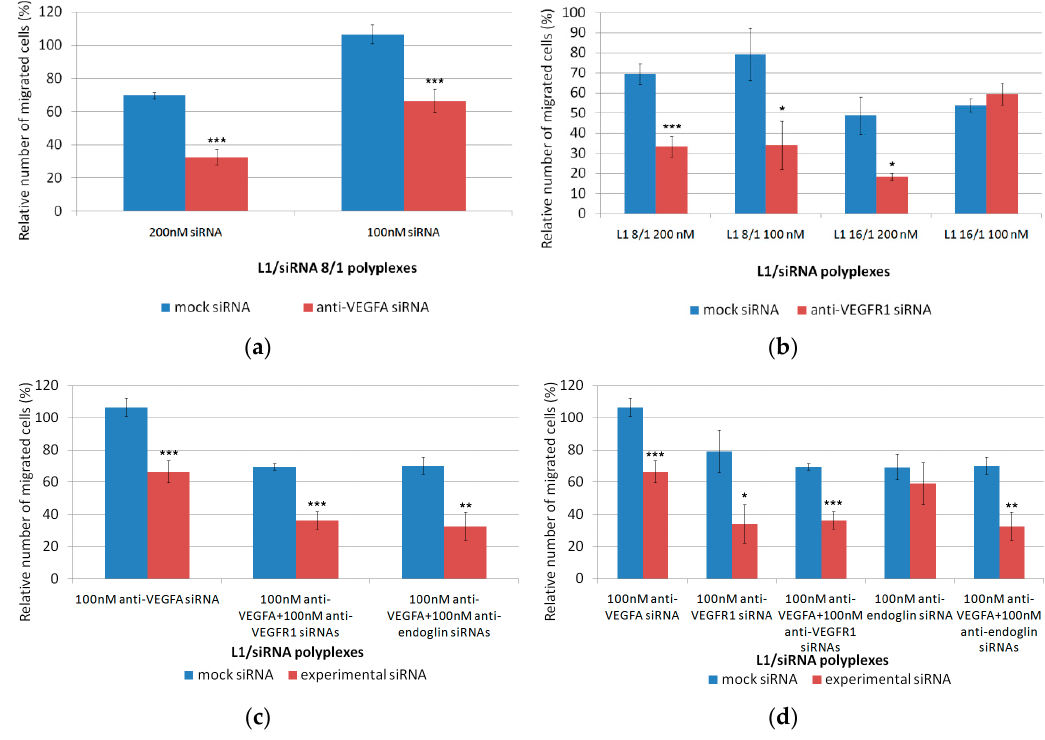
Figure 5. Number of migrated ЕА .Hy926 cells after treatment with ( a ) L1/anti-VEGFA siRNA, ( b ) L1/anti-VEGFR1 siRNA, ( c ) L1/ anti-endoglin siRNA, and ( d ) L1/mixed siRNA complexes. * p < 0.05, ** p < 0.01, *** p < 0.001 when compared with cells treated using mock siRNA.